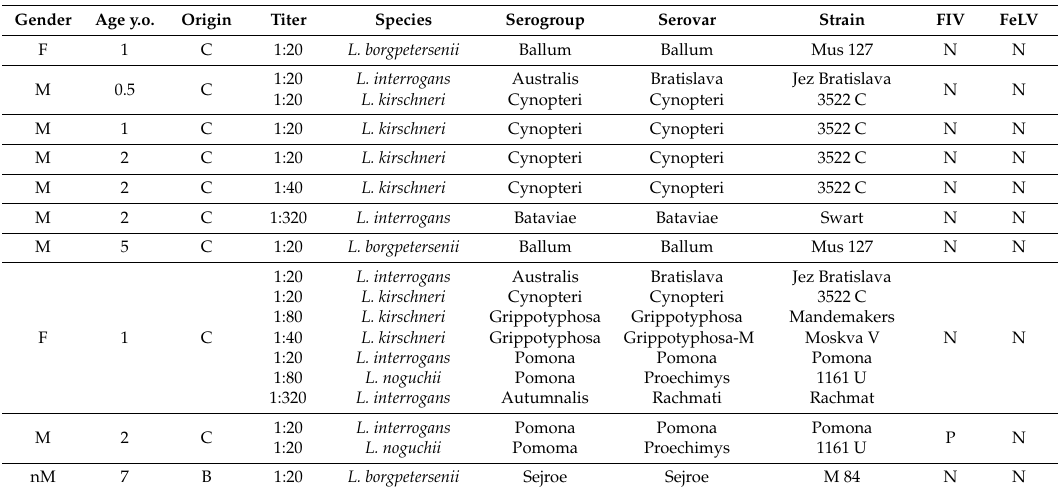
antibody titers ≥ 1:320 against the serovars Bataviae and Proechimys (Table 3). Table 3. Seropositive Microscopic agglutination test (MAT) results among 244 cats tested in Spain. Gender Age